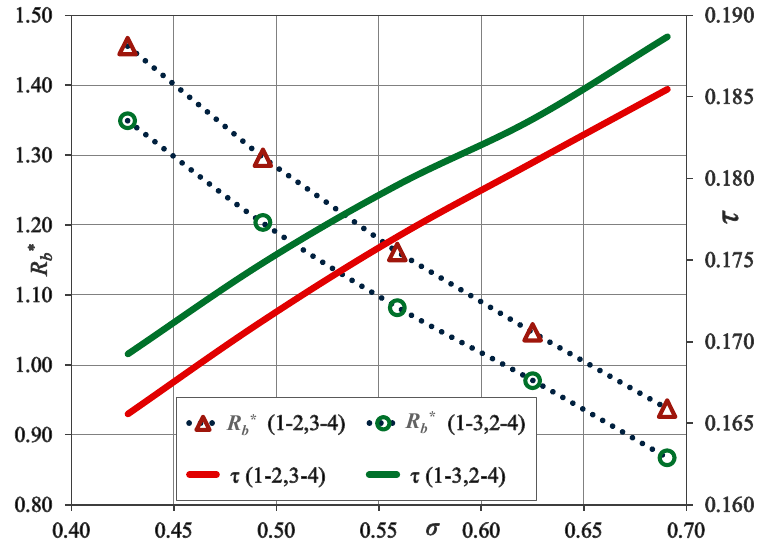
Figure 8. Variation of dimensionless thermal resistance and outlet fluid temperature versus dimensionless shank spacing. Table 6. Sensitivity of thermal resistance and outlet fluid temperature to shank spacing